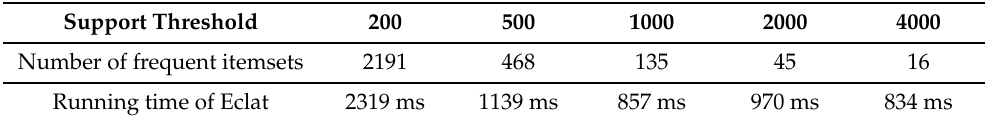
Table 5. Mining result and running time of